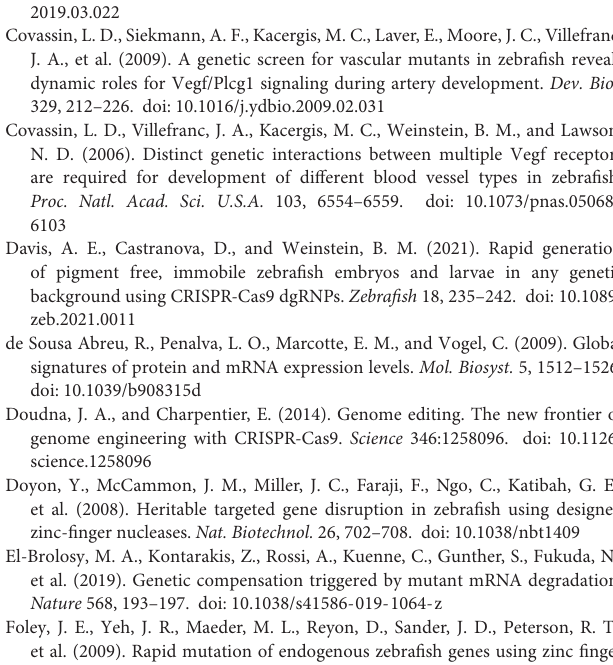
Supplementary Figure 1 | Quantification of FGPs over the optic tectum. (A) Schematic representation of the dorsal view of the zebrafish larval head. The boxed area indicates the approximate location where the confocal images of bilateral Tg(lyve1: DsRed ) + loops over the optic tectum were captured. (B) Schematic diagram of the vasculature (green) and bilateral Tg(lyve1: DsRed ) + loops (red) over the optic tectum. The areas in which FGPs were quantified are highlighted in light blue. The number of Tg(fli1: nEGFP );Tg(lyve1: DsRed ) -double positive FGPs (yellow) within the highlighted area were recorded. Supplementary Figure 2 | Generation and validation of the ccbe1 lri 97 mutant allele. (A) Predicted protein structure of zebrafish WT Ccbe1 and Ccbe1 lri 97 . WT Ccbe1 consists of a signal peptide (SP), an EGF domain (EGF), a calcium-binding